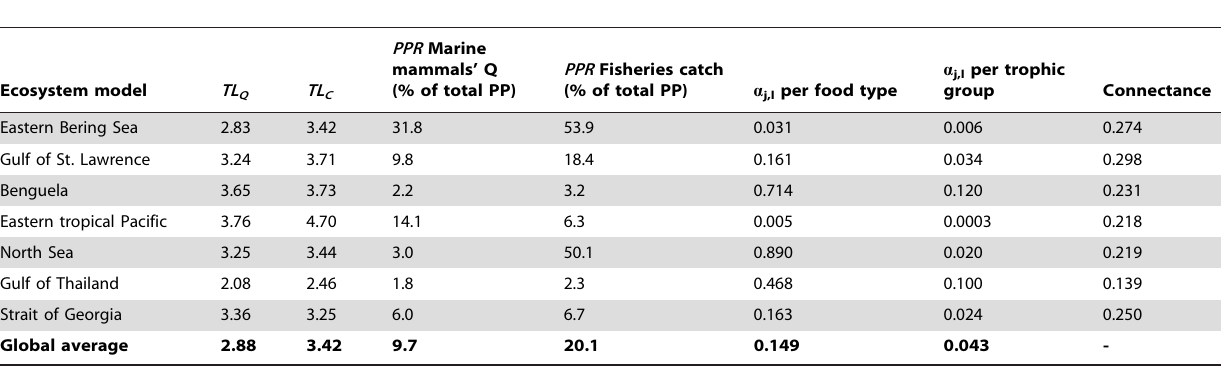
Table 2. Mean trophic level of marine mammals’ consumption ( TL Q ), Mean trophic level of fisheries’ catches ( TL C ), primary production required ( PPR ), and overlap indices ( a j,l ) for marine mammals and fisheries, and connectance in our study areas.